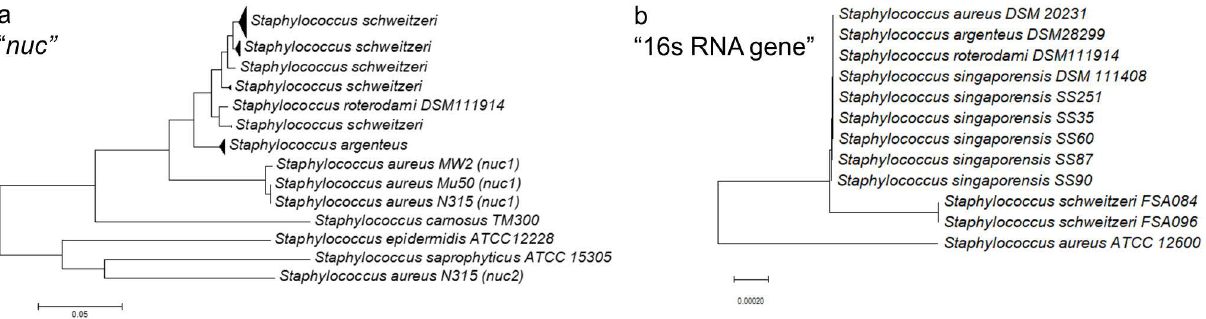
Figure 3. ( a ) Sequence-based identification of Staphylococcus schweitzeri . Neighbor-Joining trees were constructed for this review using ( a ) the complete sequences of the thermostable nuclease gene ( nuc ) and ( b ) the 16s RNA gene of members of the S. aureus complex. Sequences were obtained from GenBank ( nuc : KJ748637 to KJ748639, OE998560.1, SA0746, SA1160, SAV0815, Sca_0025, SSP1444, SE100 and 16s RNA gene: P011526.1, MF678863.1, OD916897.1, MT628672, MT628673, MT628669, MT628670, MT628671, MT628674, NR_118997.2, CCEK01000031.1, CCEL01000025.1). Therefore, to reliably identify S. schweitzeri , we suggest two screening steps by PCR ( nuc and NRPS) and a confirmation either by MLST or WGS (Figure 4).